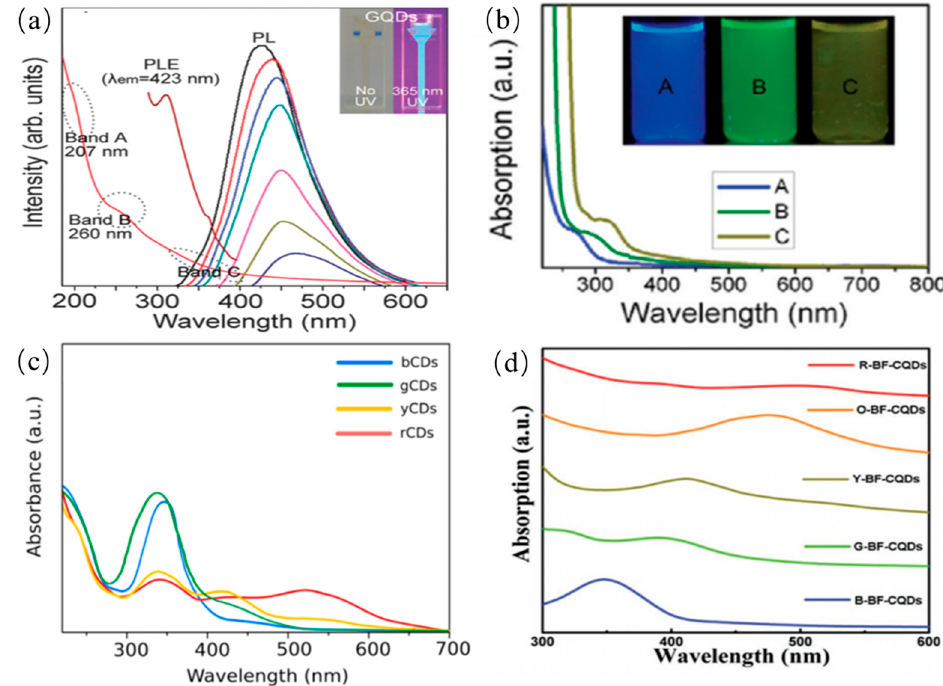
Figure 10. ( a ) UV, PL and PLE spectra of CQDs produced from graphite flakes [121]. Copyright 2012, Royal Society of Chemistry. ( b ) UV-vis spectra of CDs under different reaction temperatures, respectively [40]. Copyright 2012, American Chemical Society. ( c ) Absorption spectra for long wavelength emission CQDs [119]. Copyright 2017, American Chemical Society. ( d ) Absorption spectra for CQDs [120]. Copyright 2016, John Wiley and Sons.